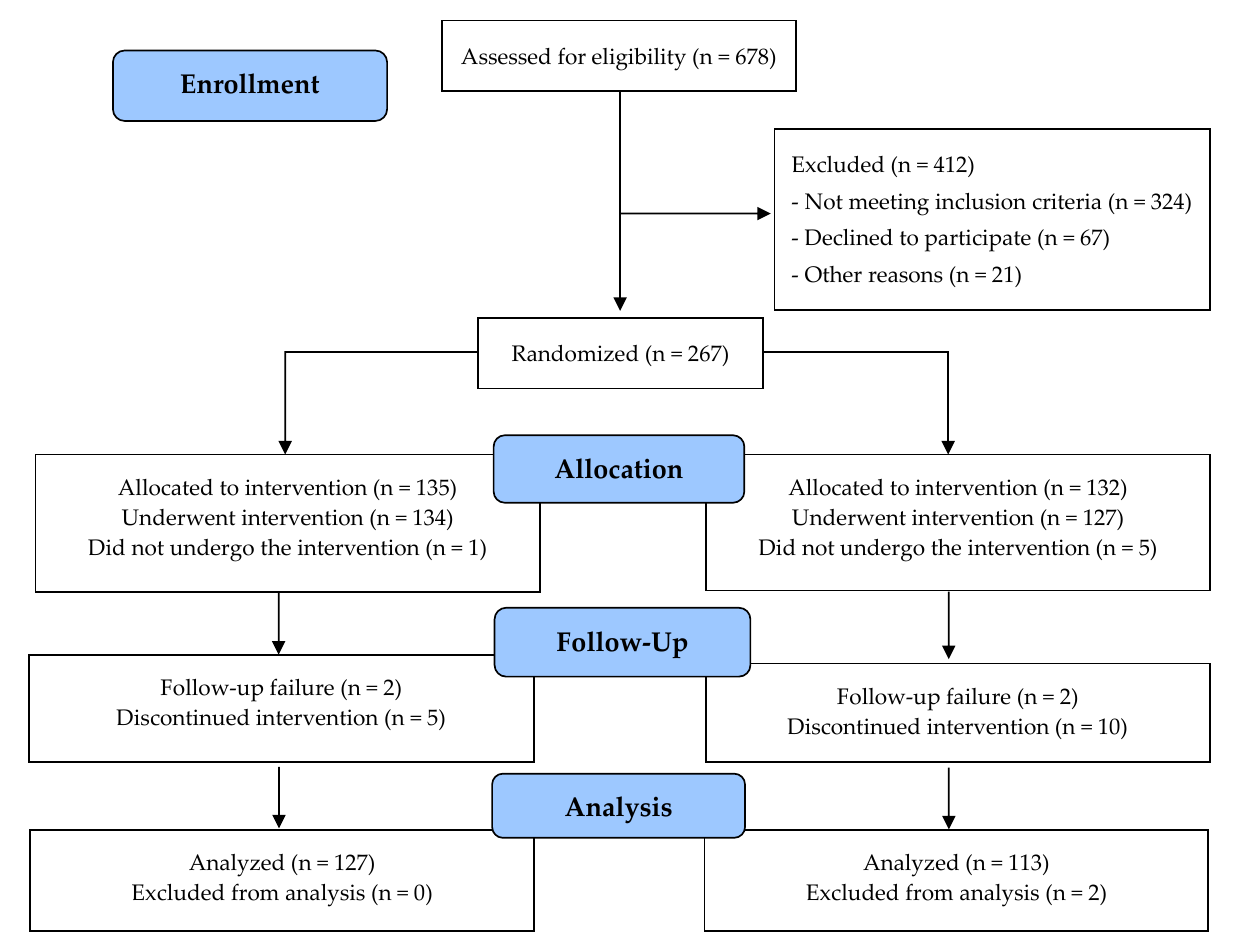
Figure 1. CONSORT flow diagram.